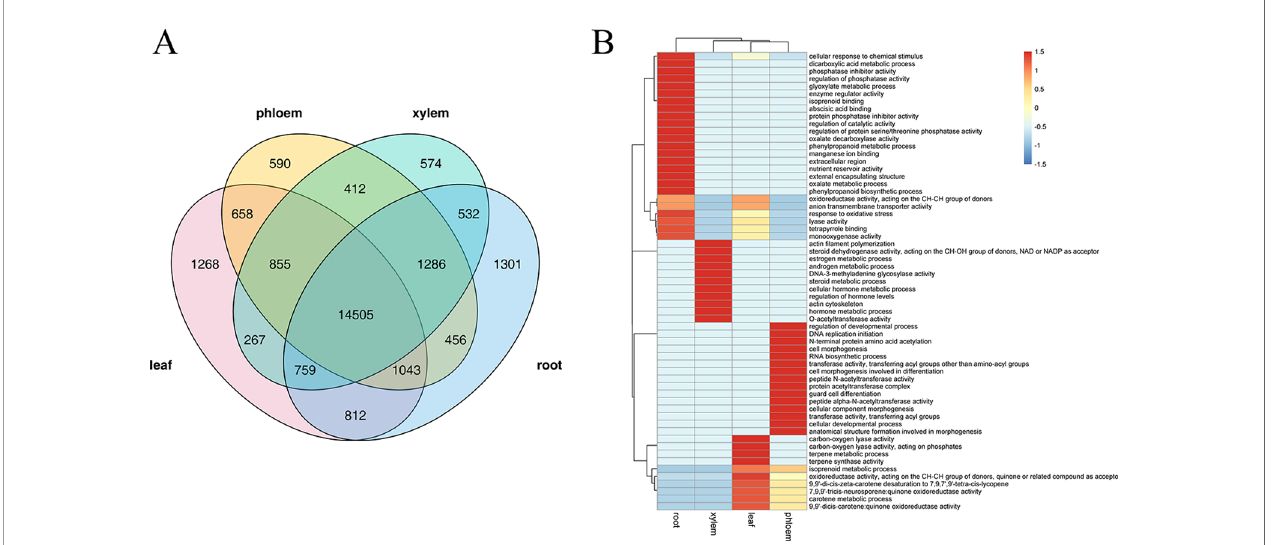
FIGURE 5 | The analysis of tissue-speci fi c alternative splicing (AS) events. (A) Venn diagram illustrating the tissue-speci fi c in leaf, phloem, xylem, and root. (B) The gene ontology (GO) enrichment heat map for tissue-speci fi c AS genes within the different tissue. GO clustered by